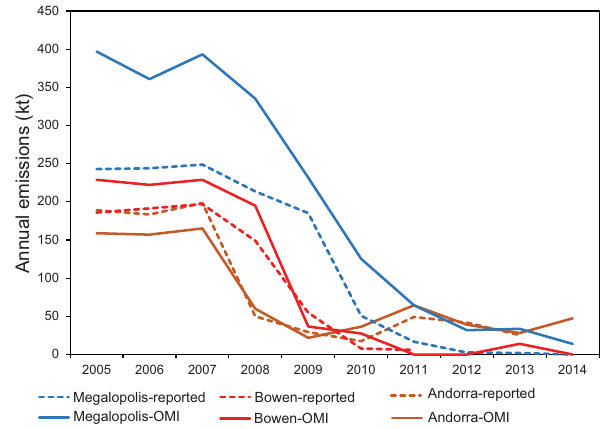
Figure 4. Time series of annual SO 2 emissions for Bowen, USA (red); Teruel (Andorra), Spain (brown); and Megalopolis, Greece (blue); power plants. Estimated from OMI and reported annual emissions for 2005–2014 are shown by the solid and dotted lines,